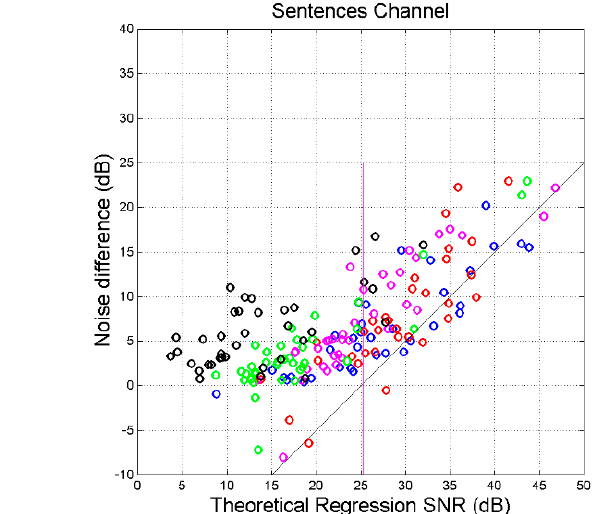
Figure 12. ( Left panel ) : Scatter plot between the theoretical partial signal ‐ to ‐ noise ratio Γ (cid:3045),(cid:3031)(cid:3003),(cid:3047)(cid:3035) and the experimental Γ (cid:3045),(cid:3031)(cid:3003),(cid:3032)(cid:3051) in the indicated cross ‐ links. ( Right panel ): Difference Γ (cid:3045),(cid:3031)(cid:3003),(cid:3047)(cid:3035) (cid:3398) Γ (cid:3045),(cid:3031)(cid:3003),(cid:3032)(cid:3051) , i.e., the ratio (expressed in dB) between the noise power in the experimental channel and that in the